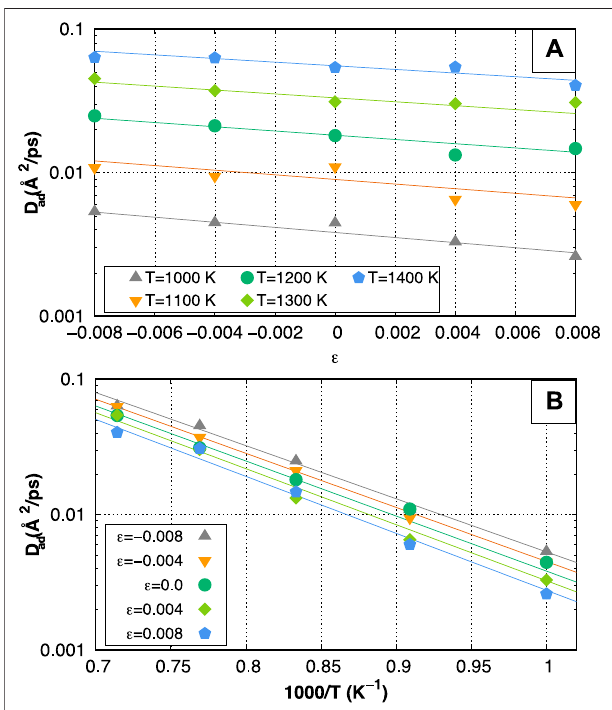
FIGURE 2 | Diffusion coef fi cient of an adatom in a W ( 110 ) surface as a function of (A) equibiaxial strain, and (B) inverse temperature.